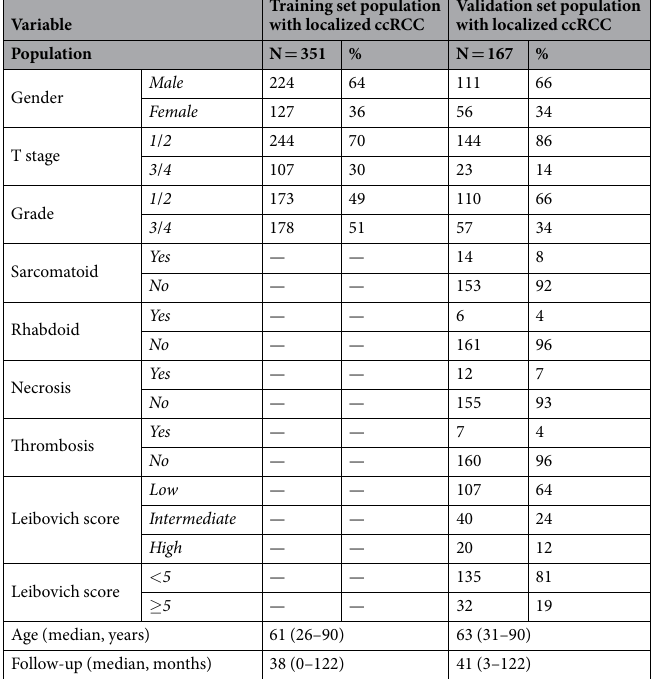
Table 1. Clinicopathologic characteristics of the patients in the training and validation sets.